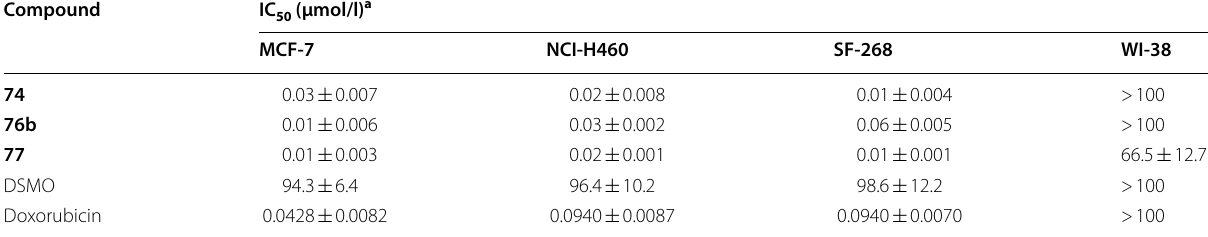
Table 15 Anticancer activity of the title compounds Compound